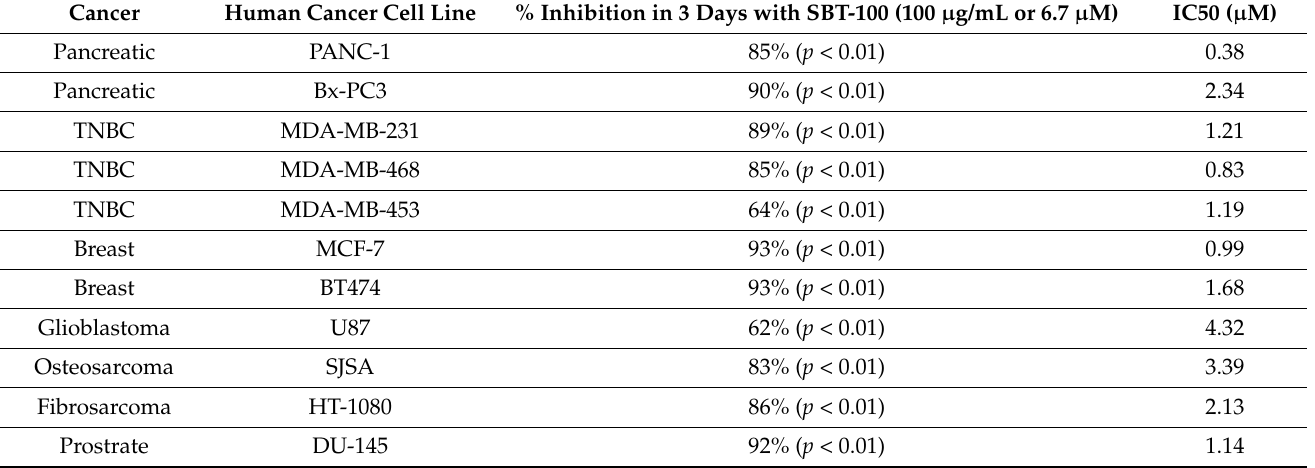
Table 2. SBT-100 inhibited in vitro growth of eleven tumor cell lines. PANC-1 has a KRAS(G12D) mutation and MDA-MB-231 has a KRAS(G13D)